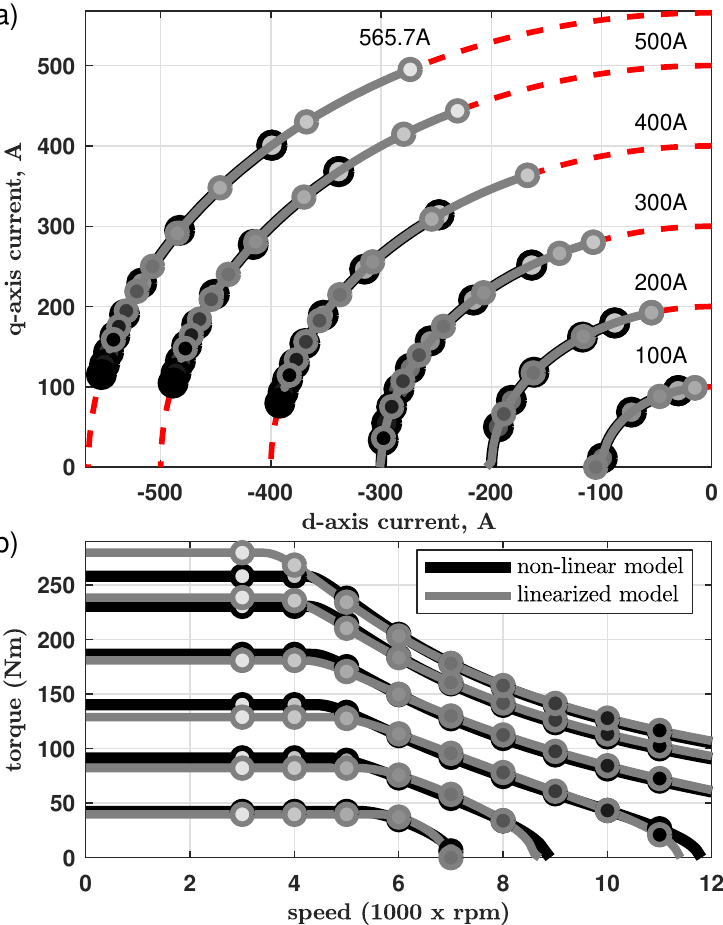
Figure 10. Comparison of the partial load torque vs. speed calculations for the BMW i3 traction drive calculated with two different methods, i.e., the numerical search algorithm based on the non-linear machine model (black) and analytical equations based on the linearized machine model (gray): ( a ) current space-vector loci, ( b ) torque vs. speed curves. The consecutive curves were calculated for many different values of the current